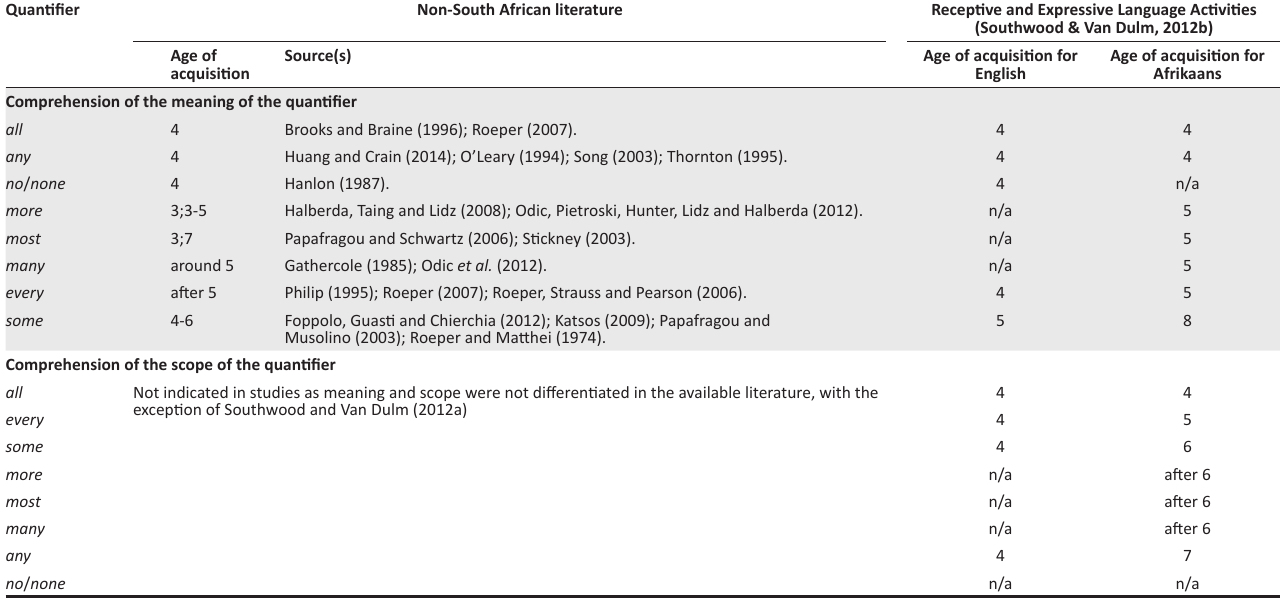
TABLE 1: Age of acquisition of quantifiers per meaning and scope.